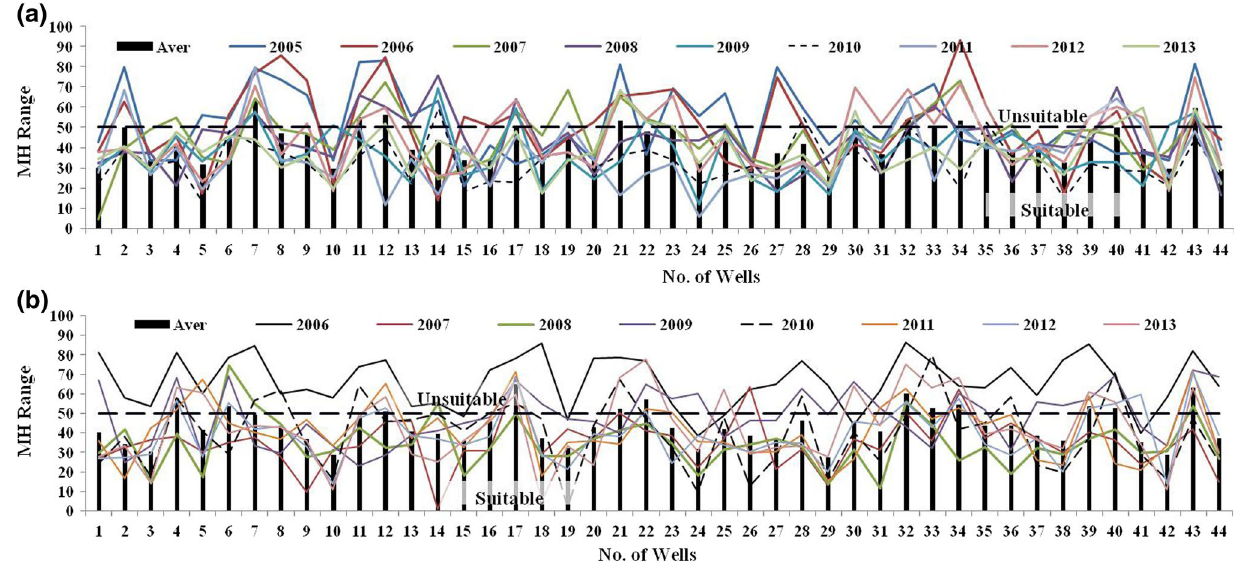
Fig. 7 a Nine-year (2005–2013) temporal representation of MH value during pre-monsoon. b Nine-year (2006–2013) temporal representation of MH value during